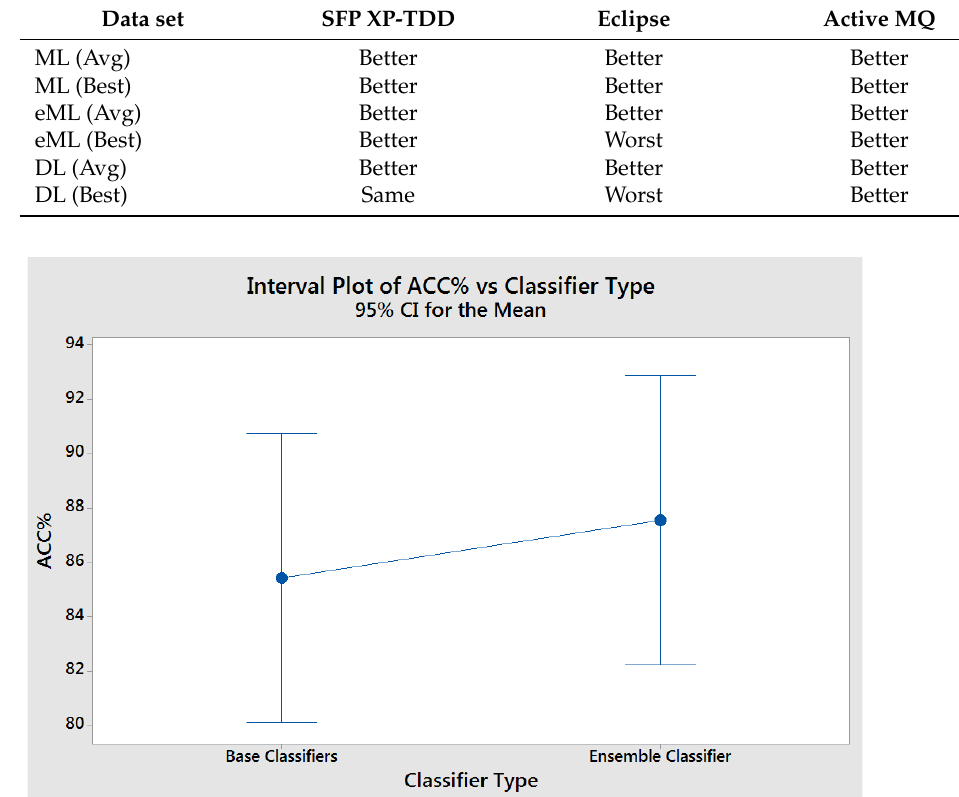
Figure 3. ACC-based average increments between base classifiers and ensemble classifiers.